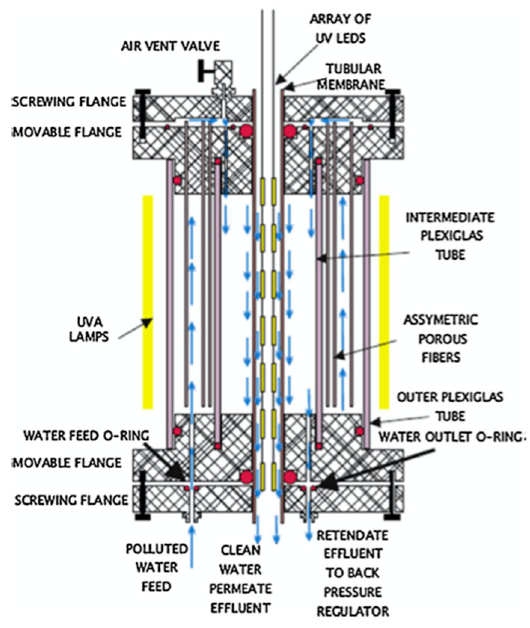
Figure 6. Schematic of the photocatalytic membrane system used in the hybrid photocatalytic/ultrafiltration tests used by Molinari et al. Reproduced with permission [101]. Copyright (2017), Elsevier.